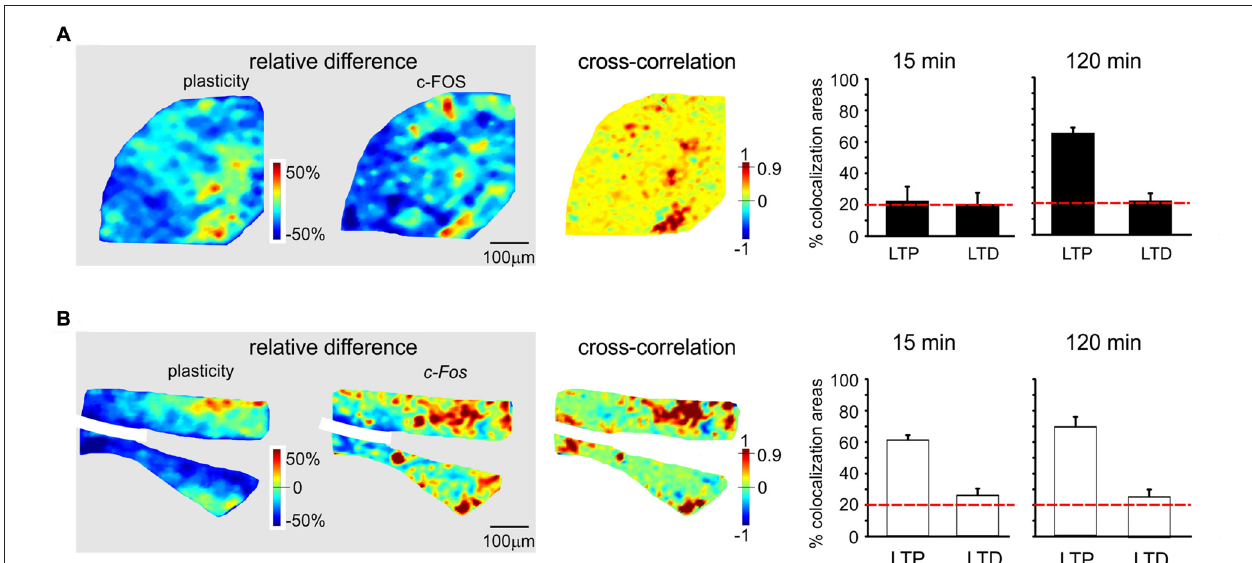
FIGURE 6 | Spatial colocalization of LTP and LTD with the levels of activation of the c-FOS system following TBS. The maps on the left show the spatial distribution of LTP and LTD (i.e relative difference in circuit responsiveness with respect to controls) and protein/mRNA expression levels (as a relative difference with respect to the average expression level; Equation 1). The map on the right shows the cross-correlation between corresponding pixels in the other two maps (Equation 2). All the maps in this figure refer to measurements taken 120 min after TBS. The histograms show the percentage area showing colocalization of LTP and LTD with the relative levels of protein/mRNA at both 15 min and 120 min following TBS. The correlation is positive when LTP is associated with expression levels above average (both values are > 0) and when LTD is associated with expression level below average (both values are < 0). Only correlations with C > 0.9 have been used to construct the histograms (the values are normalized by the area making LTP or LTD). The dashed red lines represent the level of correlation between random matrices (i.e., the level at which correlation is due to noise). (A) c-FOS protein. The area showing colocalization of plasticity with c-FOS in these maps is 52.9% for LTP and 12.5% for LTD. (B) c-Fos mRNA. The area showing colocalization of plasticity with c-Fos in these maps is 53.9% for LTP and 33.3% for